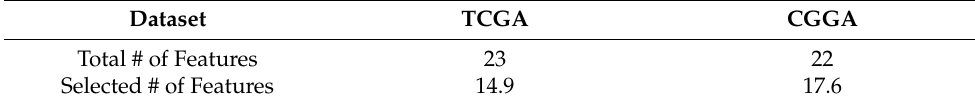
Table 5. The mean number of selected features after applying voting-based feature selection.